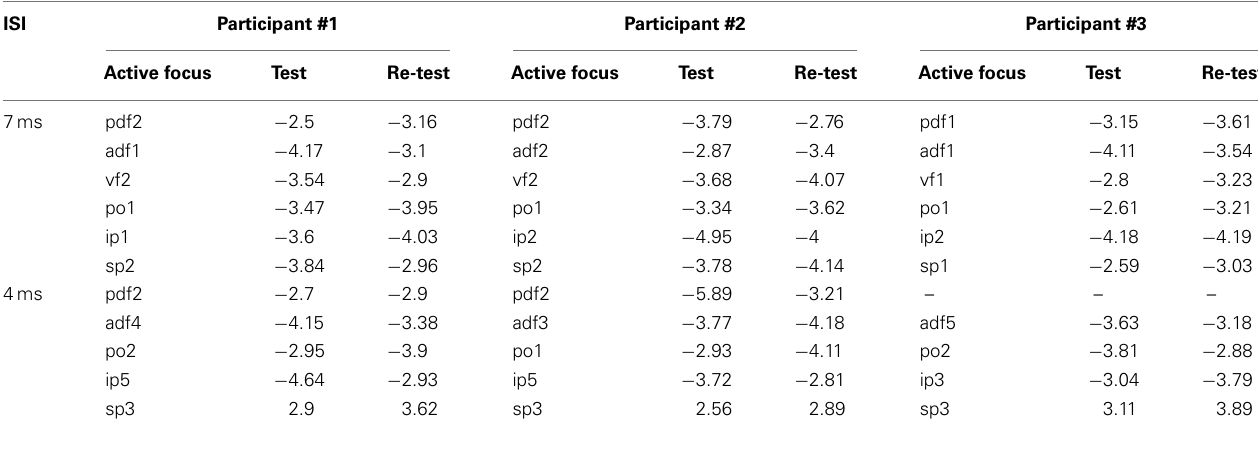
Table 3 | Side-by-side comparison of the values of t obtained in the mapping session and in the re-test session for representative active foci in the three participants and for the two